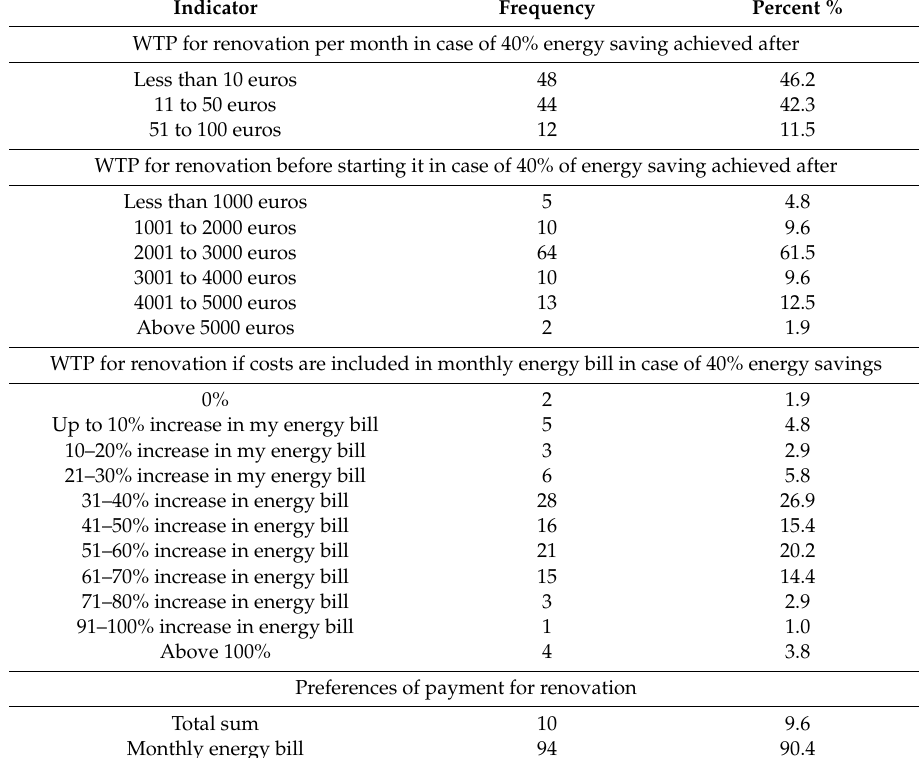
Table 6. Willingness to pay for energy